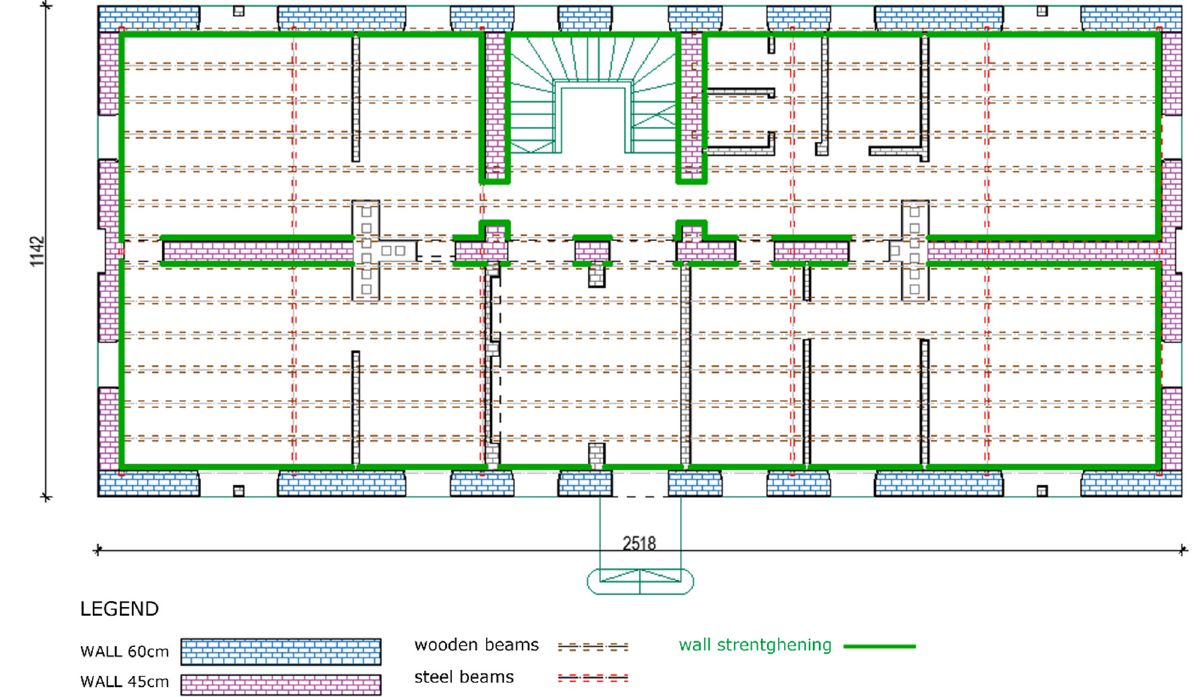
Figure 21. Proposal for reinforcement of load-bearing walls.